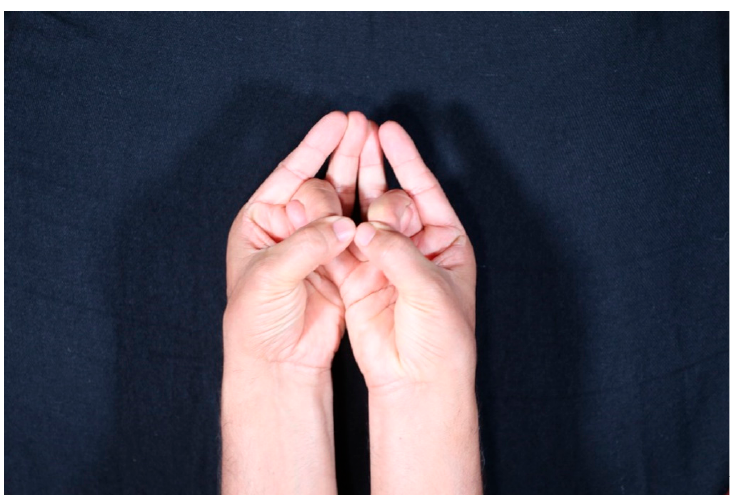
Figure 3. Unm ā din ī -Mudr ā .